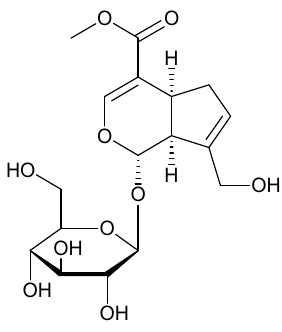
Figure 7. Geniposide. Figure 7.